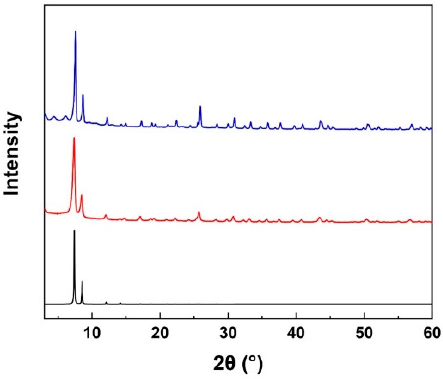
Figure 1. PXRD (powder X-ray diffraction) patterns for UiO-66 synthesised with (blue) and without formic acid (red). Simulated PXRD for UiO-66 (black) [27].